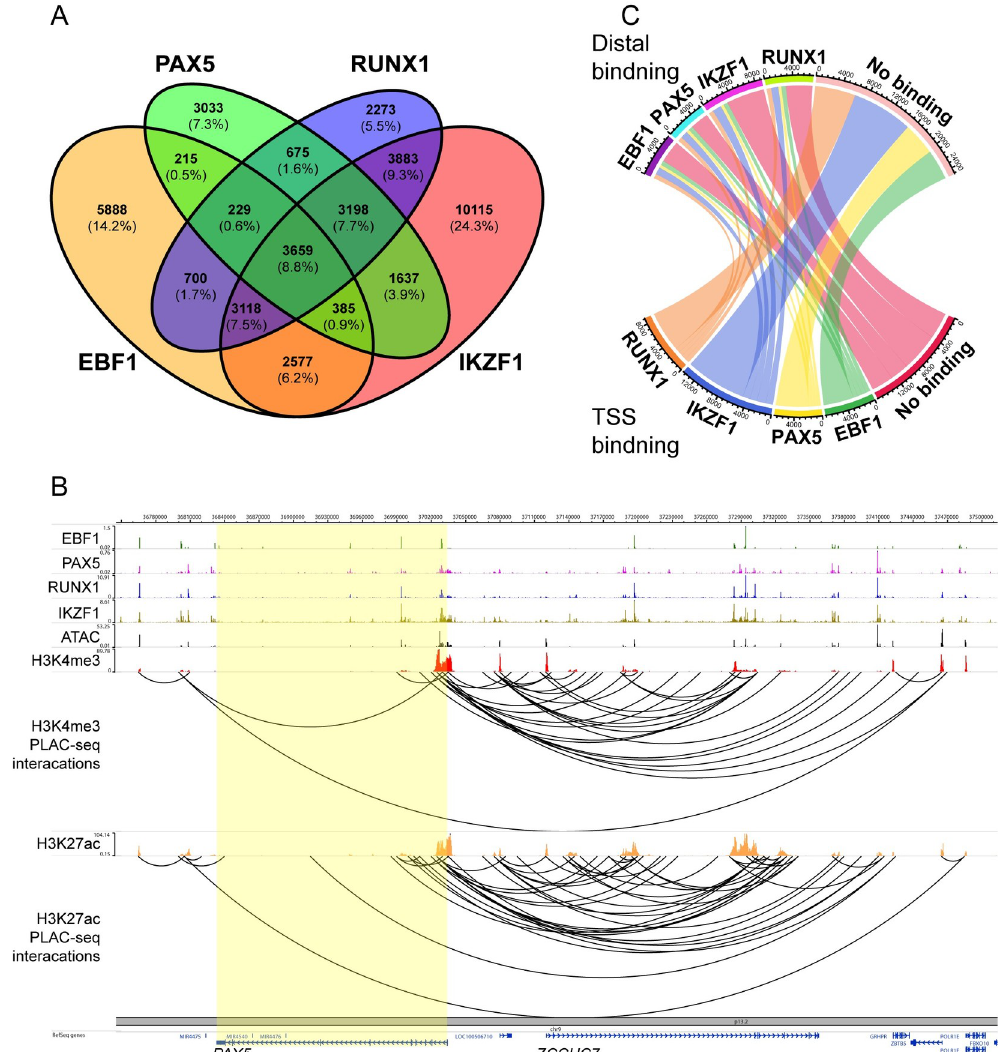
Overlapping ChIP-seq peaks were identified with the mergePeaks command in Homer. ( B ) Visualization of H3K4me3 and H3K27ac anchored PLAC-seq interactions at the PAX5 gene in NALM6 B-ALL cells. Binding of EBF1, PAX5, RUNX1 and IKZF1 as well as H3K4me3 and H3K27ac chromatin marks was determined by ChIP-seq. ATAC-seq was used to determine chromatin accessibility. The data was displayed using the WashU Genome Browser. ( C ) Chord diagram based on H3K4me3 anchored PLAC-seq from NALM6 displaying interactions between TSS and distal elements. PAX5-EBF1-RUNX1-IKZF1 gene networks anchored distal-to-TSS (transcription start site) are indicated in the diagram. Chromatin loops were filtered for overlapping PAX5, EBF1, RUNX1 or IKZF1 ChIP-seq peaks in either one or both anchor-points (for details, see Methods) with the constraints that one anchor-point had to be within 2.5kb from TSS and the other had to be located more than 2.5kb away from TSS (distal binding). The chord diagram was visualized with the circlize package in